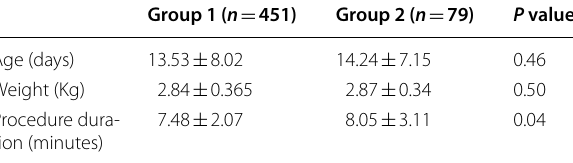
(Data were presented as mean and standard deviation, comparison was made using t-test) Group 1: Neonates with normal penile anatomy Group 2: Neonates